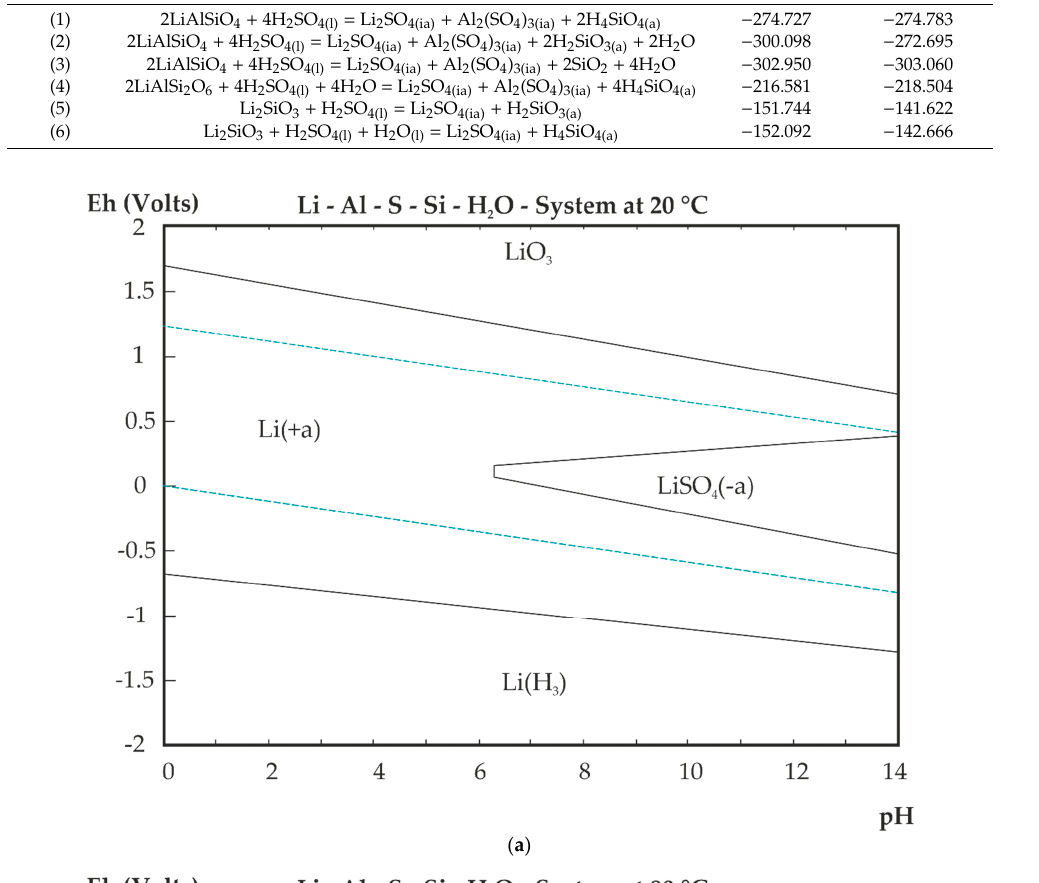
Table 3. Potential reactions of slag phases and ∆ G ◦ values in the H 2 SO 4 leaching system, data from [38]. Equation Reaction ∆ G ◦ 293.15 [kJ] ∆ G ◦ 353.15 [kJ]